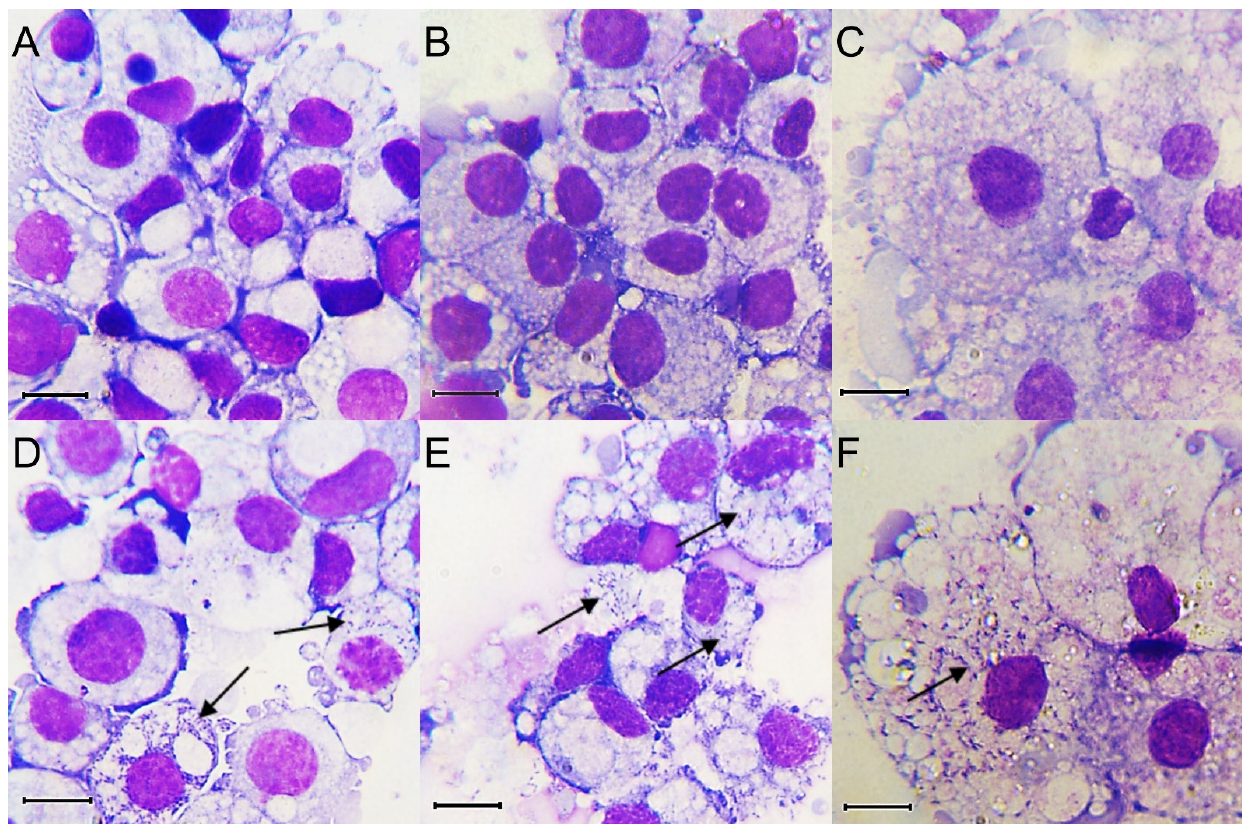
Figure 1. Giemsa-stained cytocentrifuge smears prepared pre-infection ( A – C ) and at 7 days post infection ( D – F ) with Rickettsia raoultii of tick cell lines BME/CTVM23 ( A , D ), IDE8 ( B , E ) and RSE/PILS35 ( C , F ). Arrows indicate the presence of bacteria. Scale bars represent 10 µm.